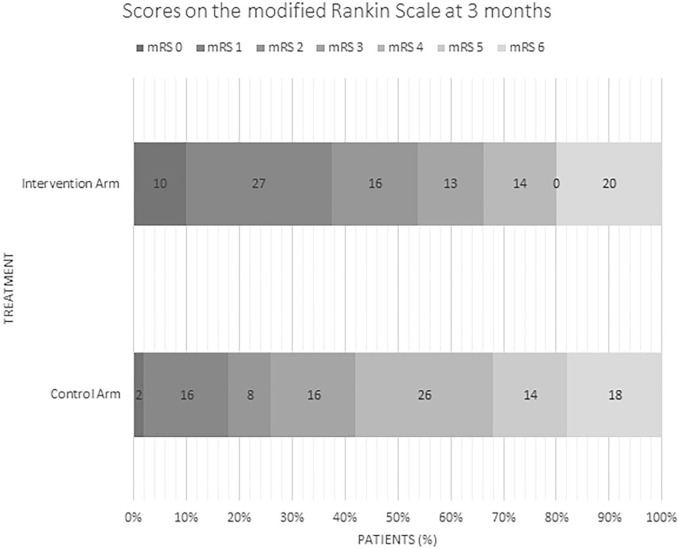
Distribution of mRS scores in intervention and control arm.